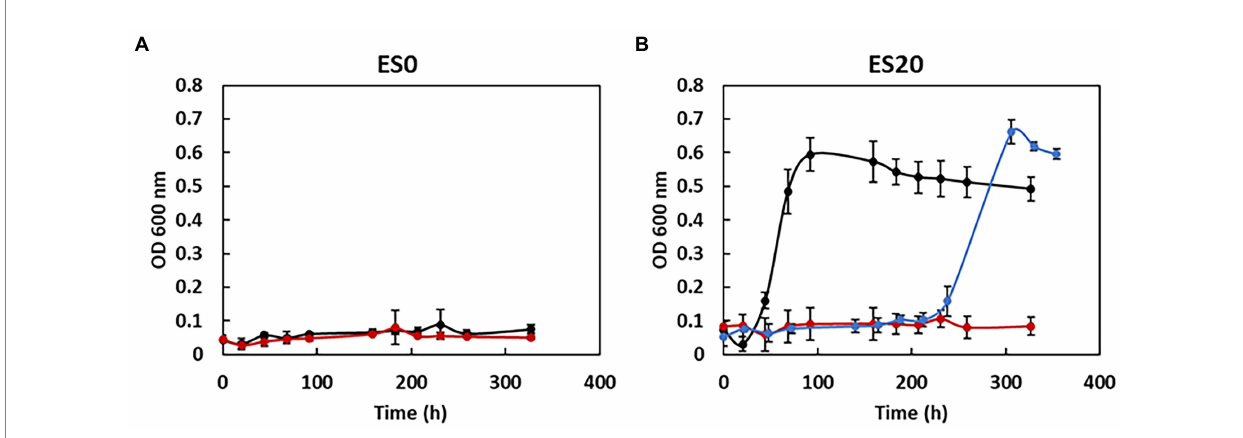
FIGURE 1 Growth curves of Solidesulfovibrio fructosivorans WT, SM4, and SM4/pBGhnd6 strains. Bacteria were grown in 100 mL serum bottles containing 90 mL of ES0 (A) and ES20 (B) media supplemented or not with 20 mM sulfate, respectively, and 40 or 60 mM ethanol as electron donor for the WT and the complementation strains, and the mutant strain, respectively. WT strain, black curves; SM4 strain, red curves; SM4/pBGhnd6 strain, blue curve. Data represent the averages of the results of three or four replicate growths. Error bars correspond to standard